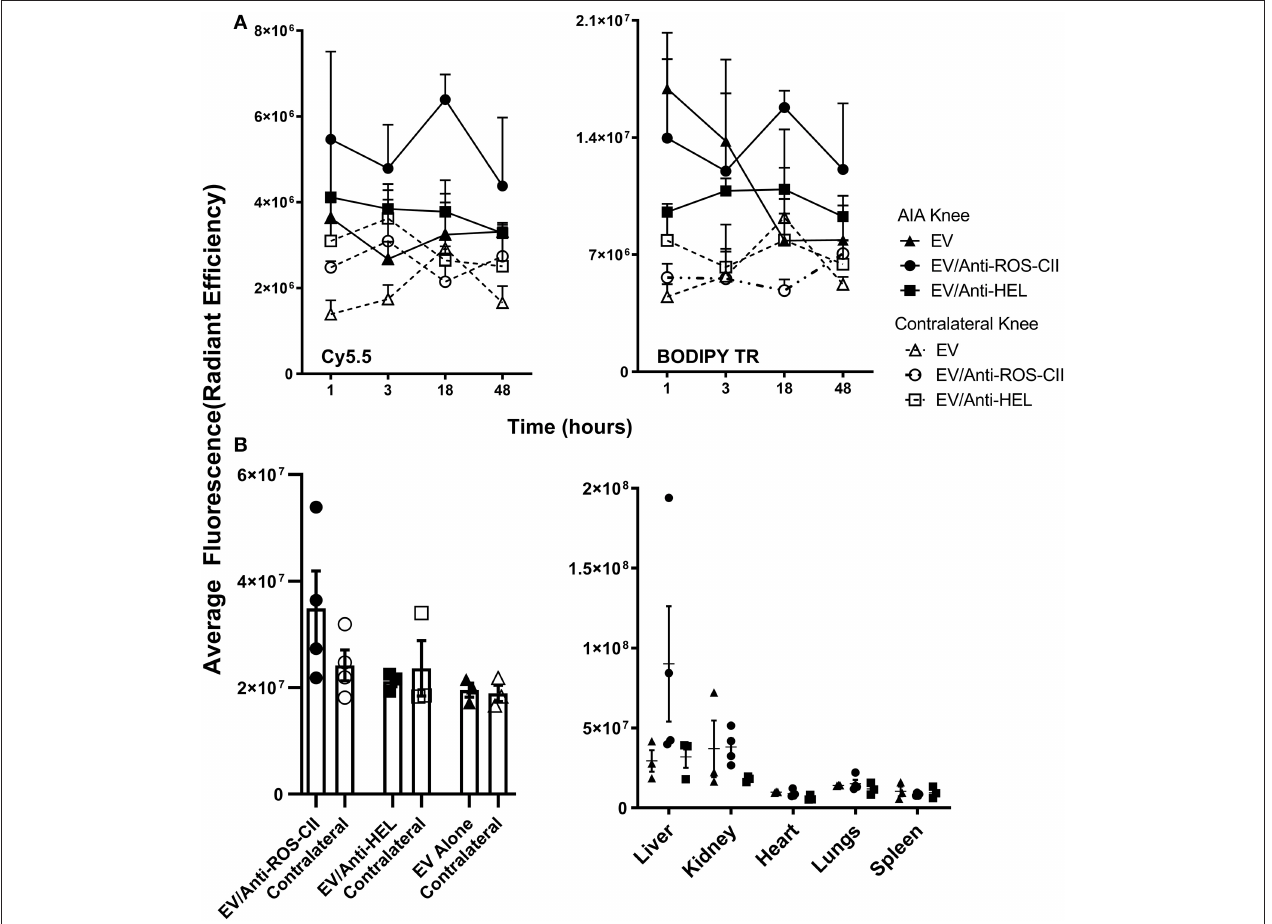
FIGURE 2 | In vivo localization of EV/anti-ROS-CII. Antigen-induced arthritis was induced in the right knee of female C57BL/6 mice. One day after the stimulation of inflammation in the right knee, mice were injected with 6 × 10 5 i.v. of either EV alone or EV/anti-ROS-CII or EV/anti-HEL. Localization of EV in the arthritic and contralateral knees was assessed by IVIS Optical Imaging. (A) A specific localization of EV/anti-ROS-CII in the arthritic knee was observed, with peak localization at 18h post-administration in both the Cy5.5 and BODIPY TR channels, indicating antibody and EV co-localization ( p = 0.009 for Cy5.5 fluorescence and p = 0.034 for BODIPY TR). (B) Knees and organs were imaged by IVIS in the BODIPY TR channel ex vivo at the end point of the experiment (48h). Mice injected with EV/anti-ROS-CII showed higher retention of fluorescence signal within the arthritic knees compared to those treated with EV alone and EV/anti-HEL-treated samples ( p < 0.05). Data are shown as mean ± SEM, n = 3 or 4 mice per group. Three-way mixed-model ANOVA was performed, with time, treatment, and knee as independent variables (the intercept and slopes of time and knee were allowed to vary for each mouse) with Holm–Sidak post-hoc tests of simple